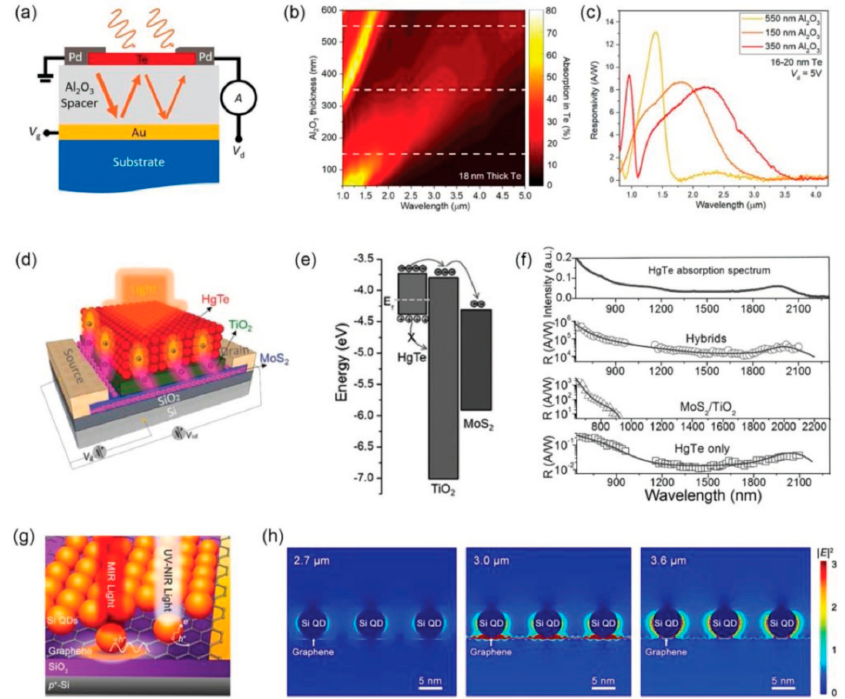
Figure 19. ( a ) Schematic diagram of a 2D Te cavity enhanced photodetector. ( b ) The change of absorption wavelength with the thickness of Al 2 O 3 . ( c ) Spectral response coefficients on Al 2 O 3 with different thickness [156]. ( d ) Experiment setup of MoS 2 /TiO 2 /HgTe-based hybrid photodetectors. ( e ) Energy band diagrams of MoS 2 –TiO 2 –HgTe hybrid structure. ( f ) Spectral responsivities for HgTe, TiO 2 /MoS 2 , and hybrid devices [297]. Copyright 2017 Wiley-VCH. ( g ) Schematic diagram of the B- doped Si QDs/graphene-based hybrid phototransistor. ( h ) The simulated distribution of the squared electric field |E| 2 at quantum dots/graphene [301]. Copyright 2017 American Chemical Society.